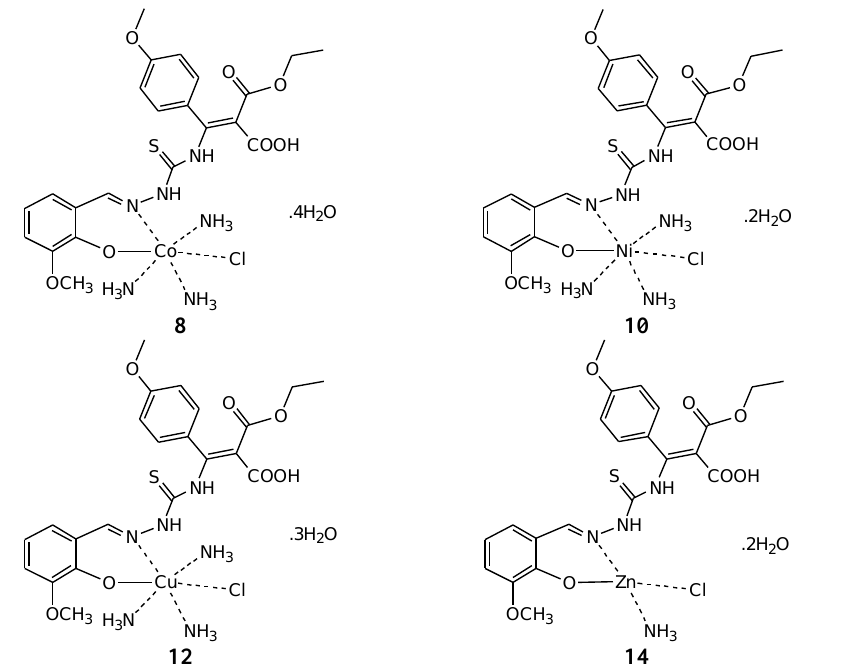
Figure 2. Proposed structures of 1:1 MTSC complexes ( 8 , 10 , 12 , 14 ).